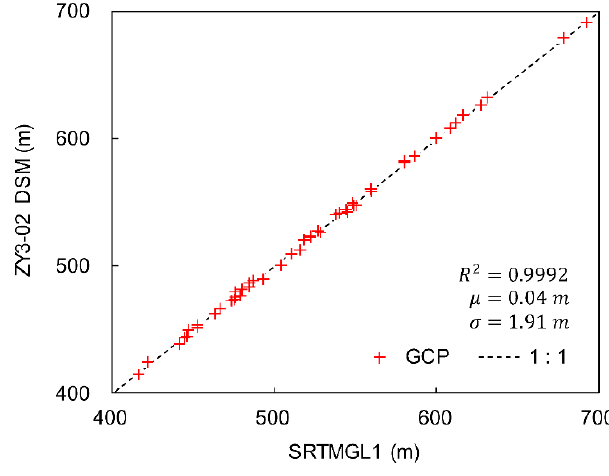
Figure 6. Comparison of the ZY3-02 DSM and SRTMGL1 at the locations of the GCPs. After the stepwise process, the red band and green band were selected as the predictors of the